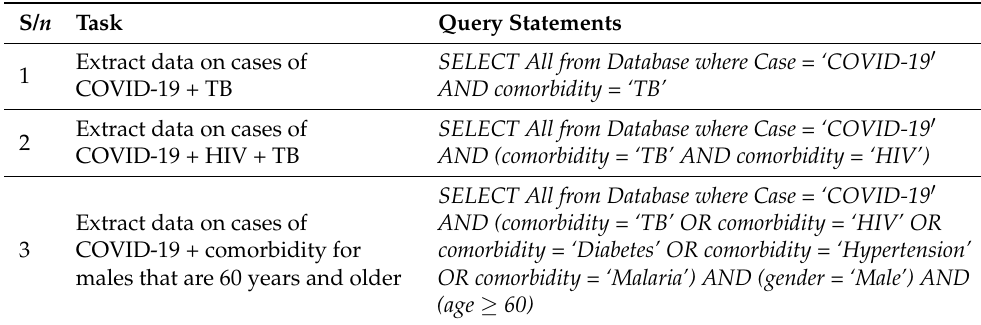
Table 2. Query statements for data extraction and data filtering from the